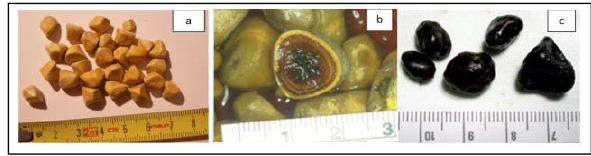
Fig.1. The types of gallstones. A: cholesterol gallstones, b: pigmented gallstones, c: mixed gallstones (Abdullah et al.,